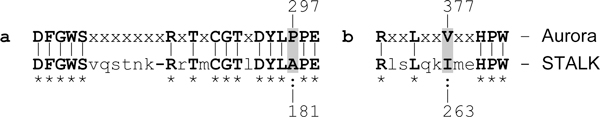
Conserved motifs typical for Aurora animal kinases found in STALK protein from V. vinifera: a - activation loop conserved motif and b - D2-type destruction box. Marked are the residues different in both proteins.